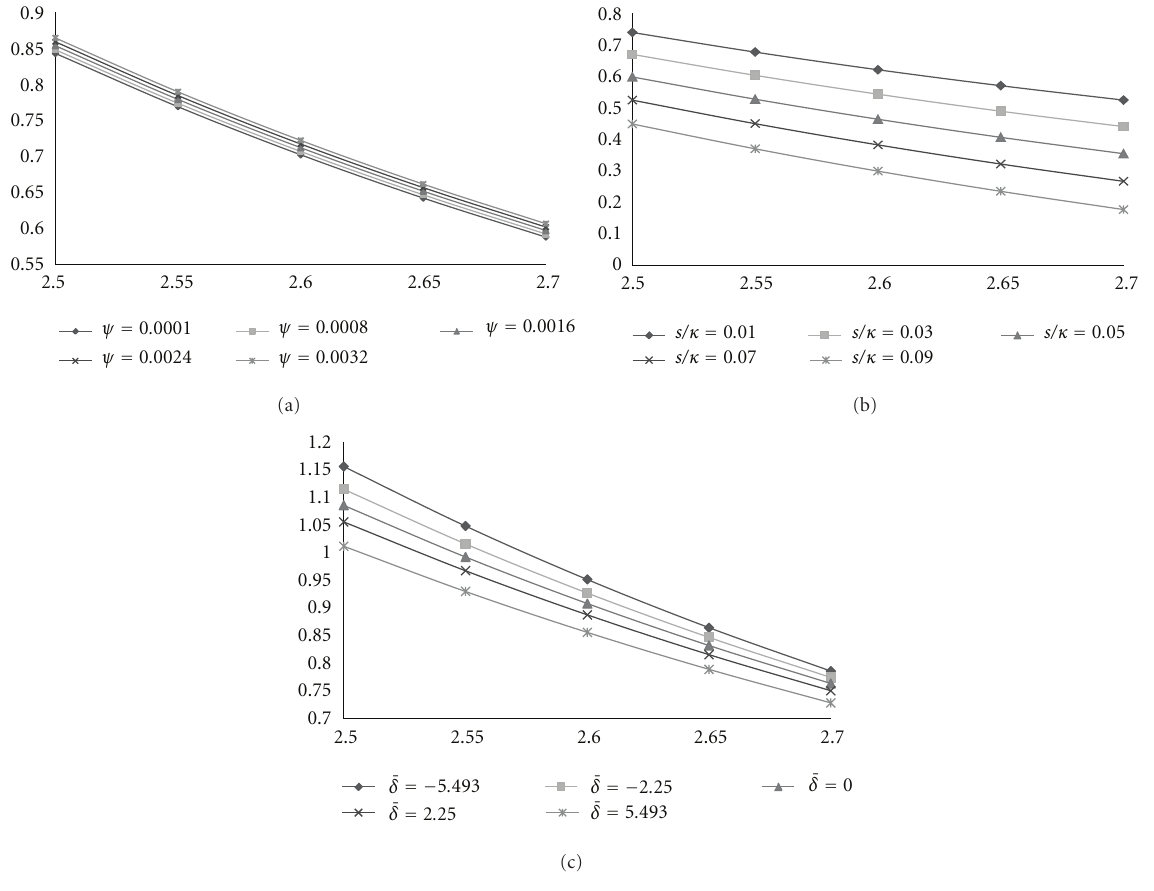
Figure 6: (a)–(c) Variation of load-carrying capacity with respect to m and ψ , s/κ , δ .